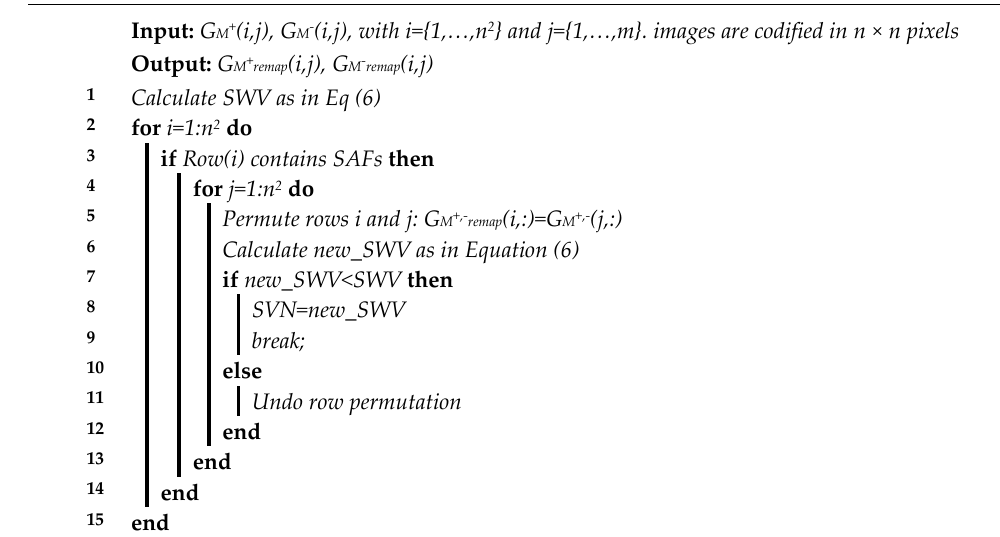
Algorithm 2: SWV-minimisation-based row permutation